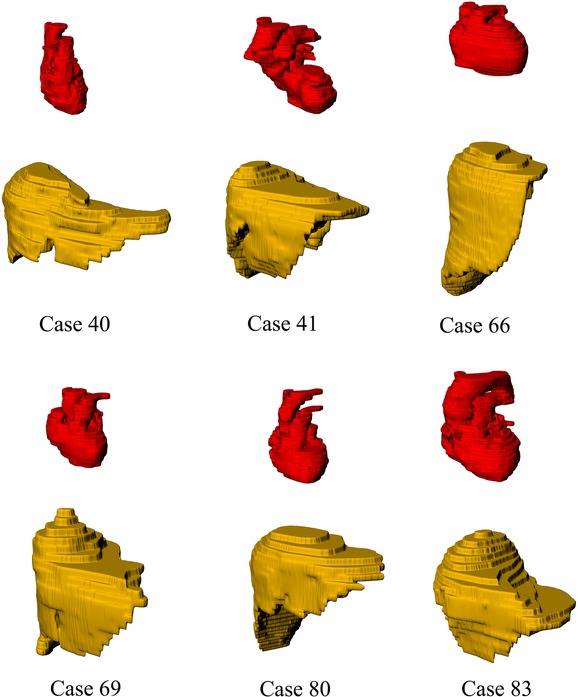
Three-dimensional models of the heart and liver of six patients who belong to the same height/weight percentile.